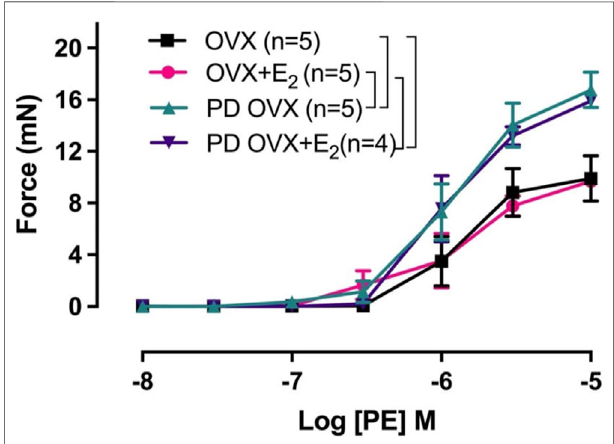
FIGURE 6 | Concentration-response curve (CRC) to phenylephrine (PE, 10 − 8 to 10 − 5 M) in intact mesenteric arterial rings of ovariectomized (OVX) and E 2 replaced(OVX+E 2 )controlandprediabetic(PD)rats.Dataareexpressedas mean ± SEM. n = 4 – 5 per group. Brackets indicate signi fi cant differences between groups ( p < 0.05), analyzed using two-way ANOVA with repeated measures followed by Tukey ’ s post hoc test.